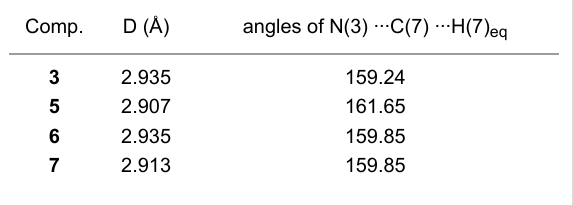
Table 1: Distances (Å) of N ∙∙∙ C(7) and angles (°) of N(3)–C(7)–H(7) eq for 3 , 5 , 6 , and 7 . Comp.